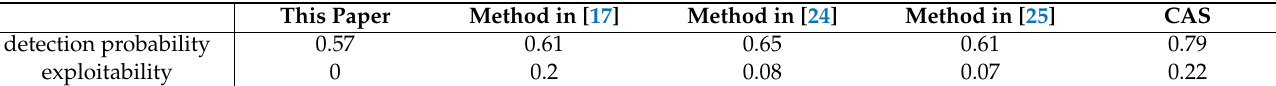
Table 7. The comparison between the proposed method and other existing